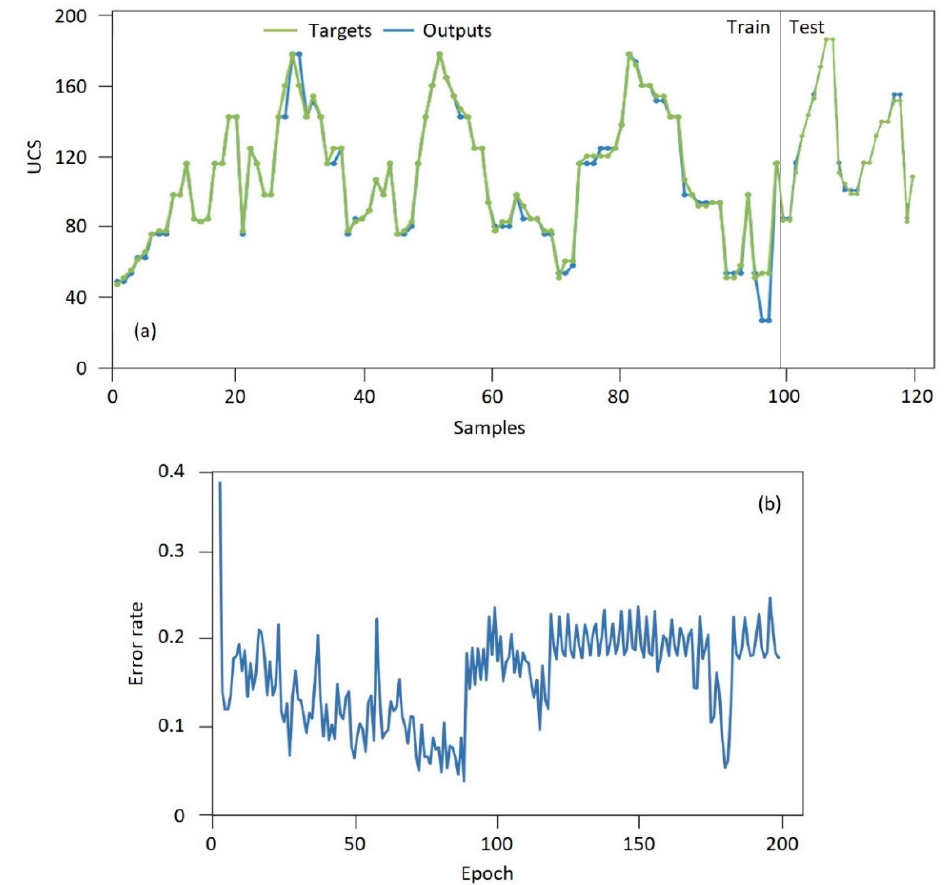
Figure 12. The corresponding ( a ) predicted and measured values and ( b ) prediction error